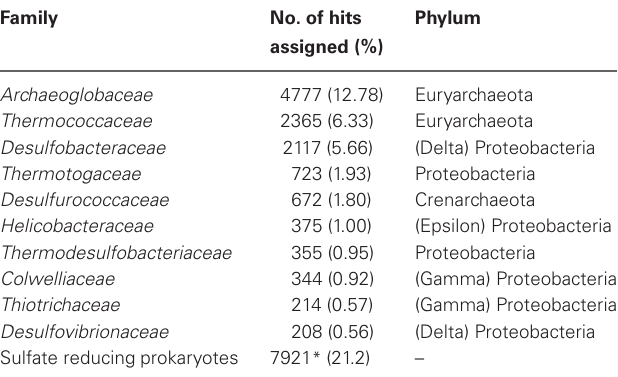
Table 3 | Top families with the most hits